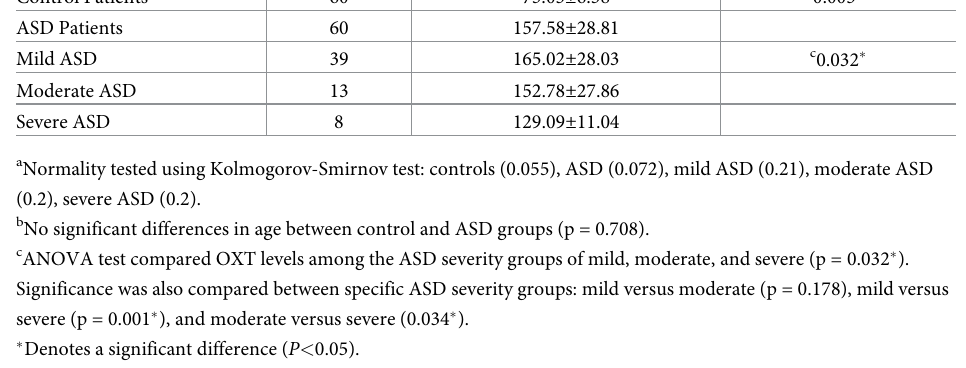
Table 2. ELISA serum OXT levels among study participants.